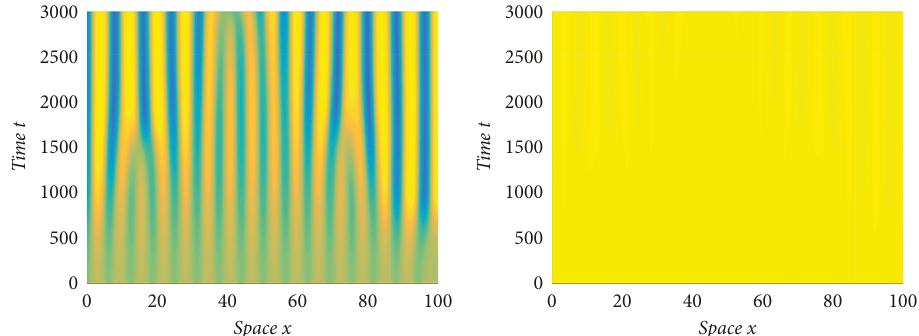
Figure 6: Turing patterns of prey and predator when Turing instability occurs.